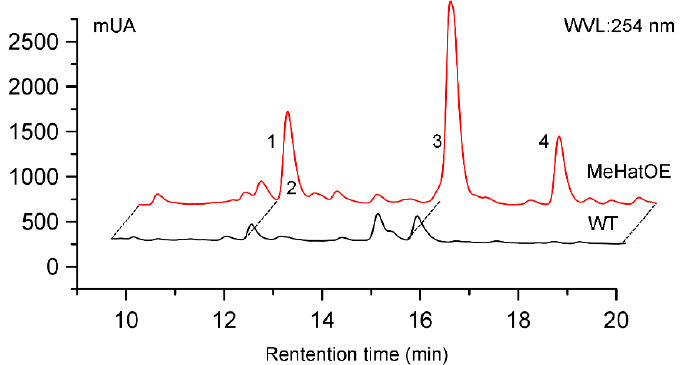
Figure 1. High-performance liquid chromatography (HPLC) chromatograms of the EtOAc extracts from the culture of WT (black) and MeHatOE (red), respectively (Chromatographic conditions: 0–2 min 60% MeOH in water, 2–25 min 60–100% MeOH / H 2 O, 25–30 min 100% MeOH, t = 30 min, 1.0 mL / min, 254 nm).